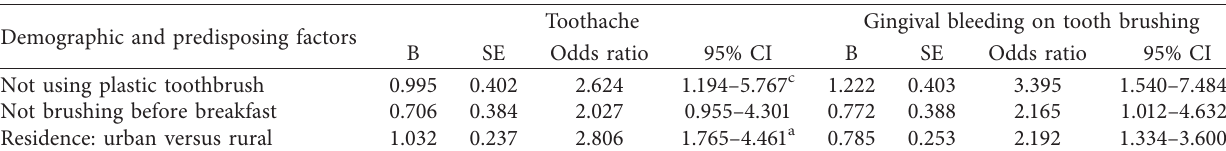
Table 5: Binary logistic regression analyses of toothache and gingival bleeding in relation to knowledge of oral hygiene, oral hygiene practices, and demographic factors among primary schoolchildren in Lilongwe, Malawi.